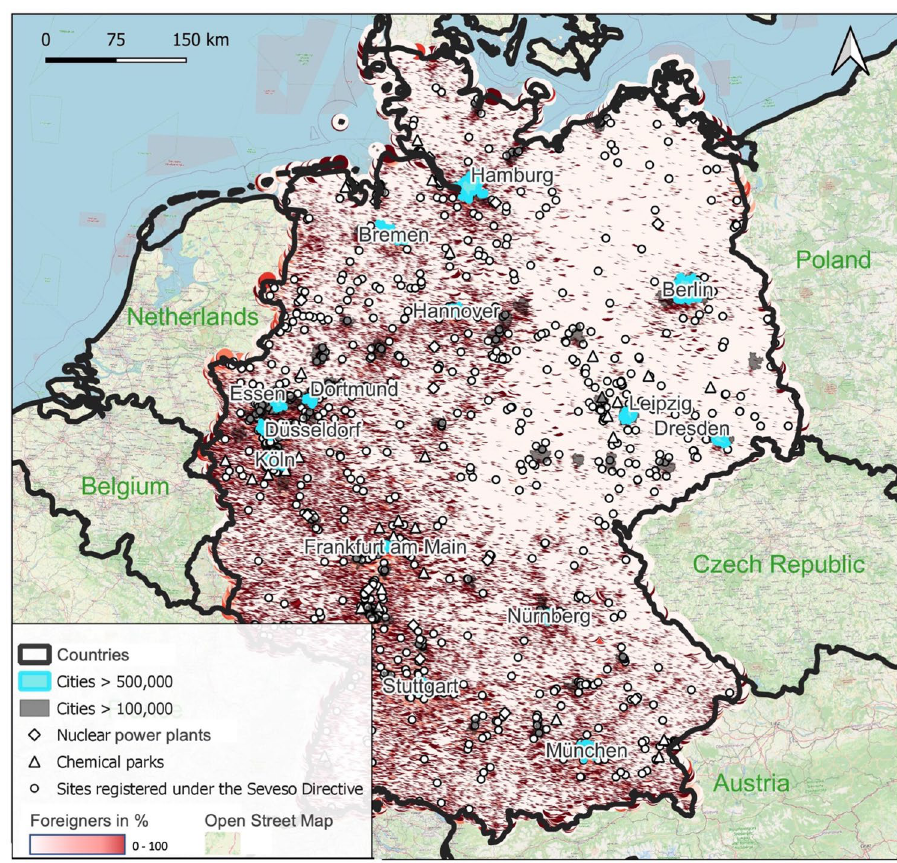
Fig. 4 Foreigners per km 2 and location of potentially hazard- ous sites in